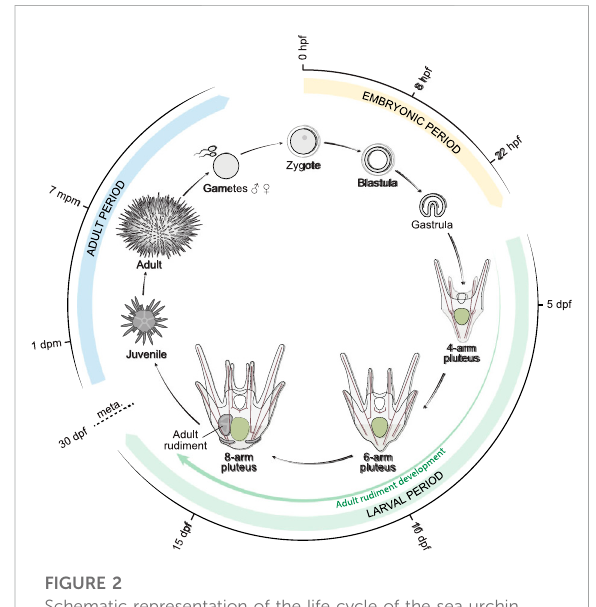
FIGURE 2 Schematic representation of the life cycle of the sea urchin Paracentrotus lividus . Approximate timing for each of the represented stages is provided based on our rearing conditions at 18 ° C. dpf: days post-fertilization; dpm: days post- metamorphosis; hpf: hours post-fertilization; meta.: metamorphosis; mpm: months